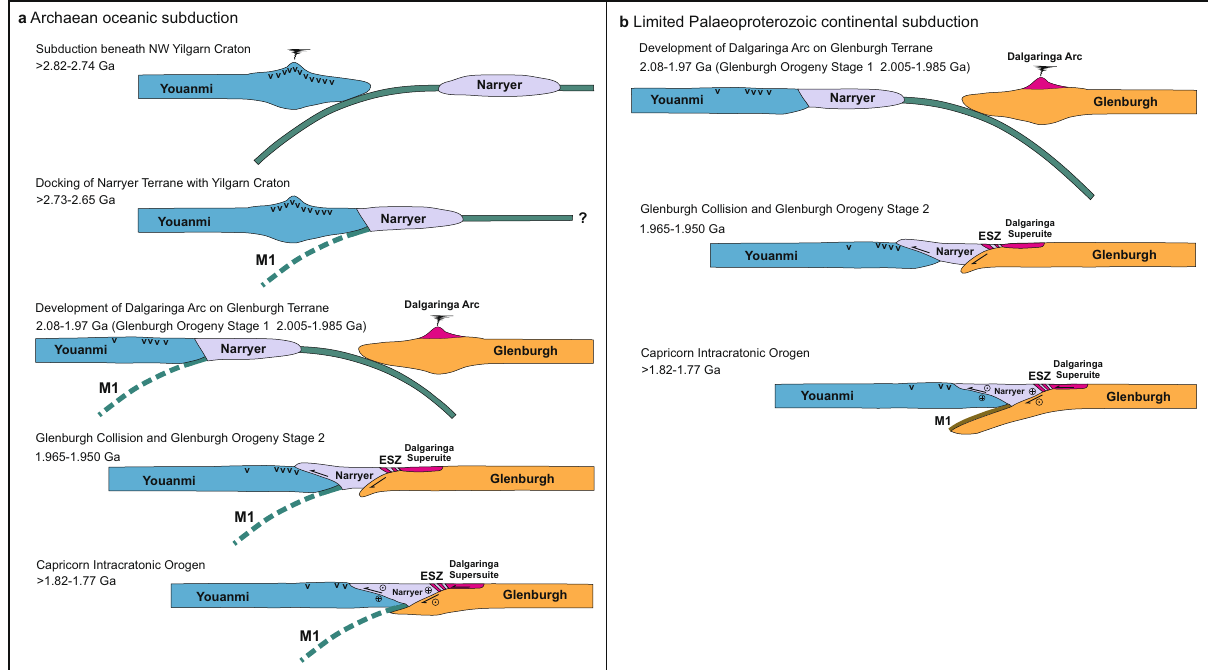
Fig. 4 Summary of two alternative interpretations of the evolution of the northwest margin of the Yilgarn Craton. a Subduction beneath the northwest Youanmi Terrane of the Yilgarn Craton, with the related emplacement of boninitic rocks and sanukitoids, terminated with docking of the Narryer Terrane, and left a remnant scar in the uppermost mantle. The two-stage collision of the Glenburgh Terrane with the Yilgarn Craton 36,47 created the Erabiddy Shear Zone (ESZ), and further obducted the Narryer Terrane onto the lower crust of the Youanmi Terrane, a process which largely concluded with the intracratonic Capricorn Orogen. b During assembly of the West Australian Craton the Glenburgh Terrane was thrust beneath the Narryer Terrane, which had previously docked with the Youanmi Terrane during the Neoarchaean. In the subsequent Capricorn Orogen, the Glenburgh Terrane was partly subducted beneath the edge of the lithospheric root of the Yilgarn Craton, creating the seismic re fl ectors that mark the top of deeply underthrust continental crust. The obduction of the Narryer Terrane largely terminated at this time. v — indicates Archaean volcanic rocks with arc af fi